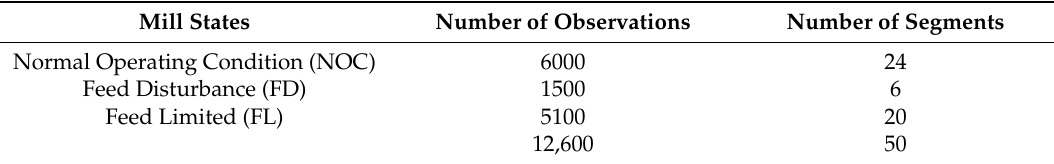
Table 1. Mill load measurements and number of time series segments for b = 250.